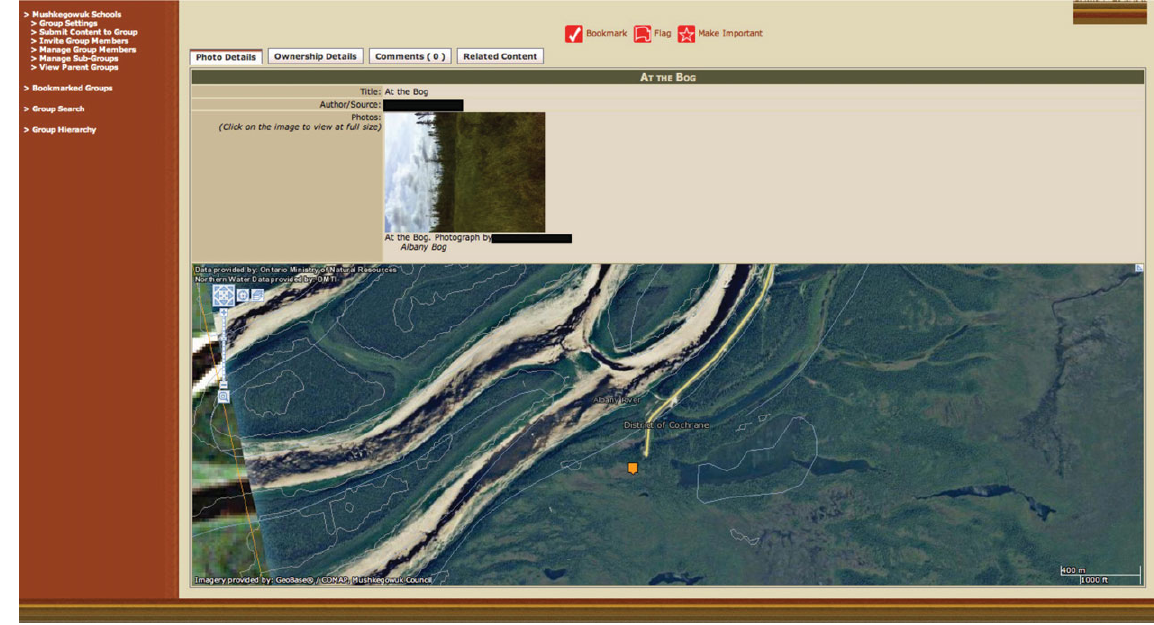
(Colour online) Screenshot of the collaborative-geomatics informatics tool, displaying a photograph taken by a student of the bog they visited during the camp.